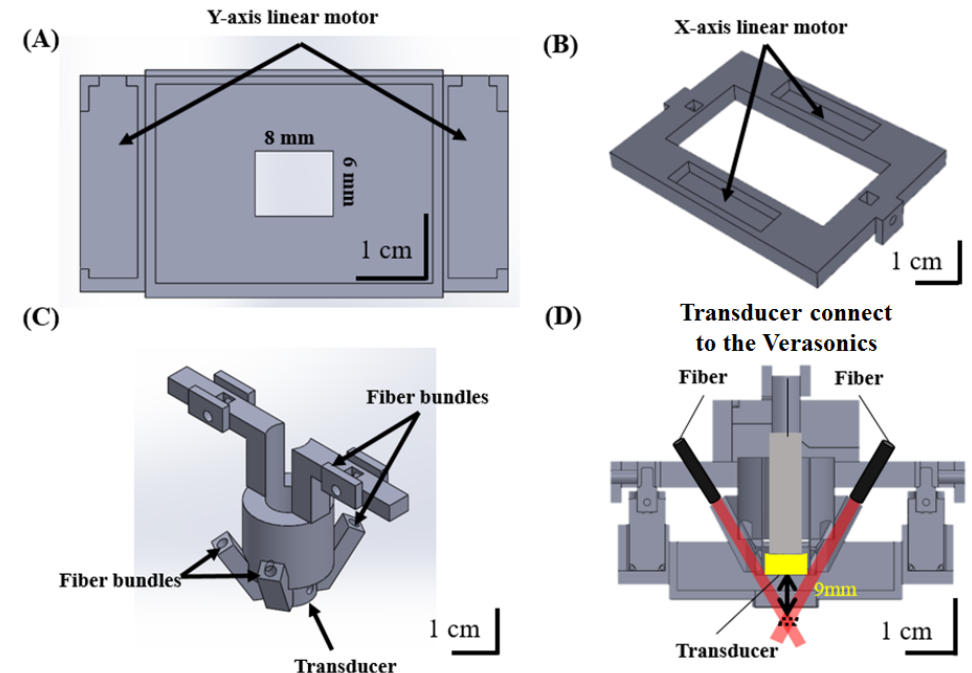
Figure 2. Diagram of the developed hmPAI system introducing each size, component, and assembly. ( A ) Holder for the y -axis linear motor. Black arrows indicate the positions of two y -axis motors. ( B ) Holder for the x -axis linear motor. Black arrows indicate the positions of the x -axis motors. ( C ) Holder for the 48 MHz transducer and fiber bundles. Black arrows indicate where the fiber bundles and transducer are placed. ( D ) Cross-sectional view of the hmPAI system after assembly.